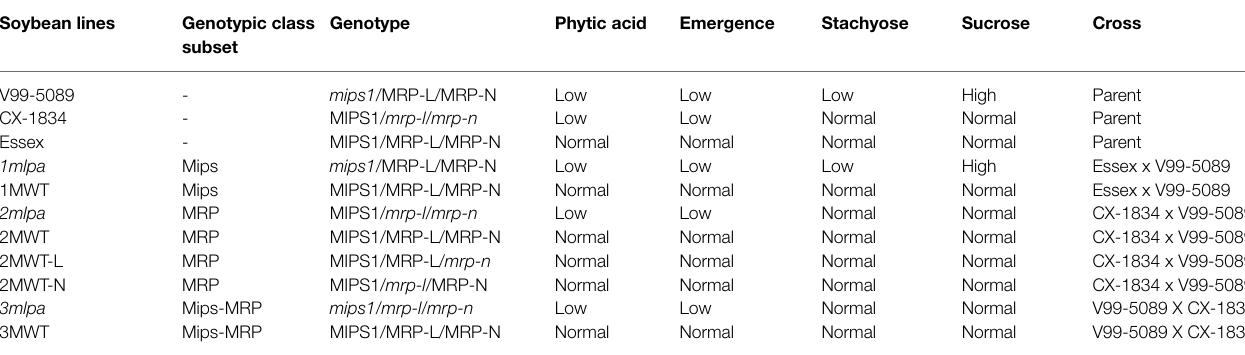
TABLE 1 | Characteristics and classification of parental and experimental soybean lines. Soybean